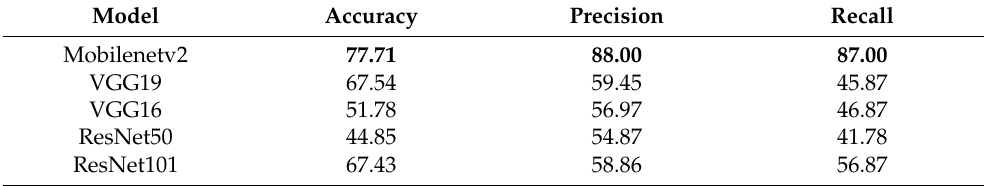
Table 5. Classification, precision, and recall (%) on enhanced dataset using log